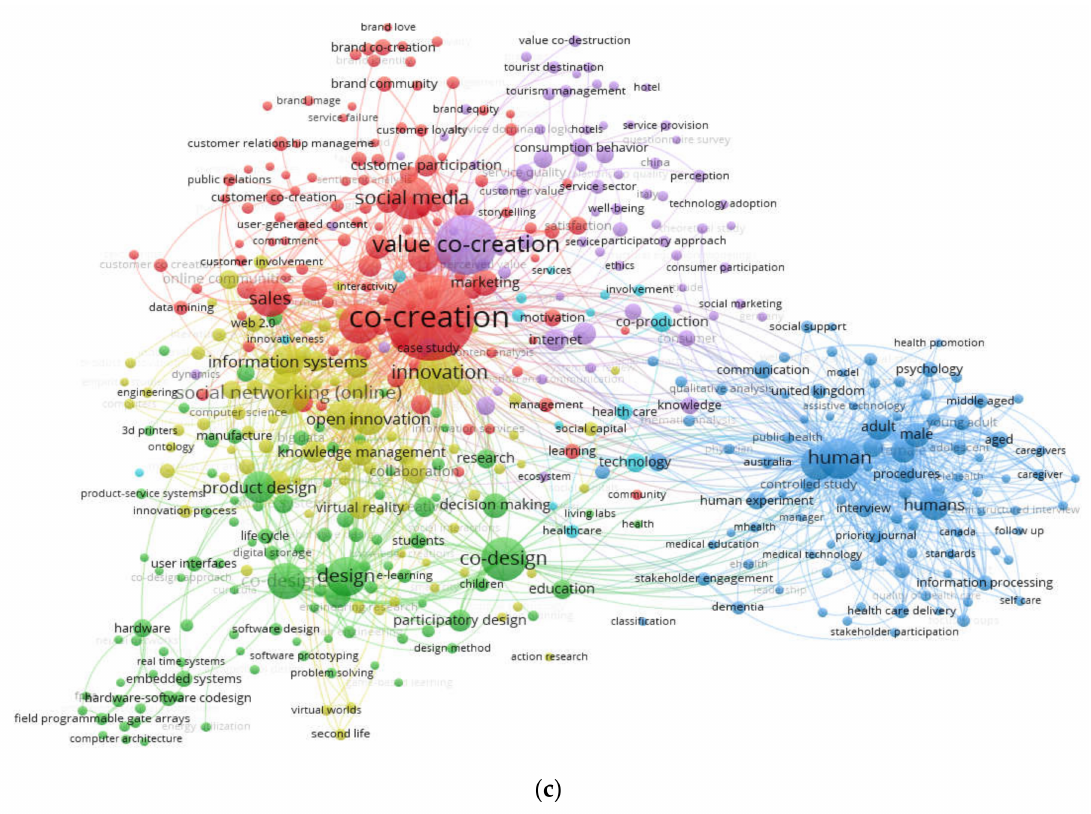
Figure 6. Network visualization of keywords clustering in product participatory design, co-design, and co-creation literature. ( a ) Keywords of product participatory design. ( b ) Keywords of product co-design. ( c ) Keywords of product